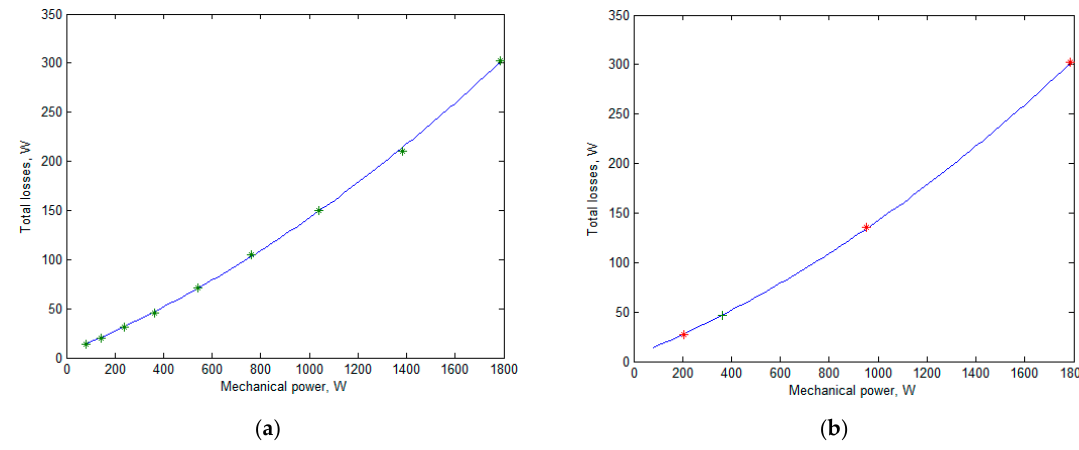
Figure 9. The calculated losses of the optimized FSG design and their quadric approximation: ( a ) the points of the nine-mode profile and the approximating quadric trinomial; ( b ) the same quadric trinomial and the points of the two-mode and three-mode substituting profiles. The main parameters of the FSG before and after the optimization are given in Table 9. Table 9. The main parameters of the FSG before and after optimization.